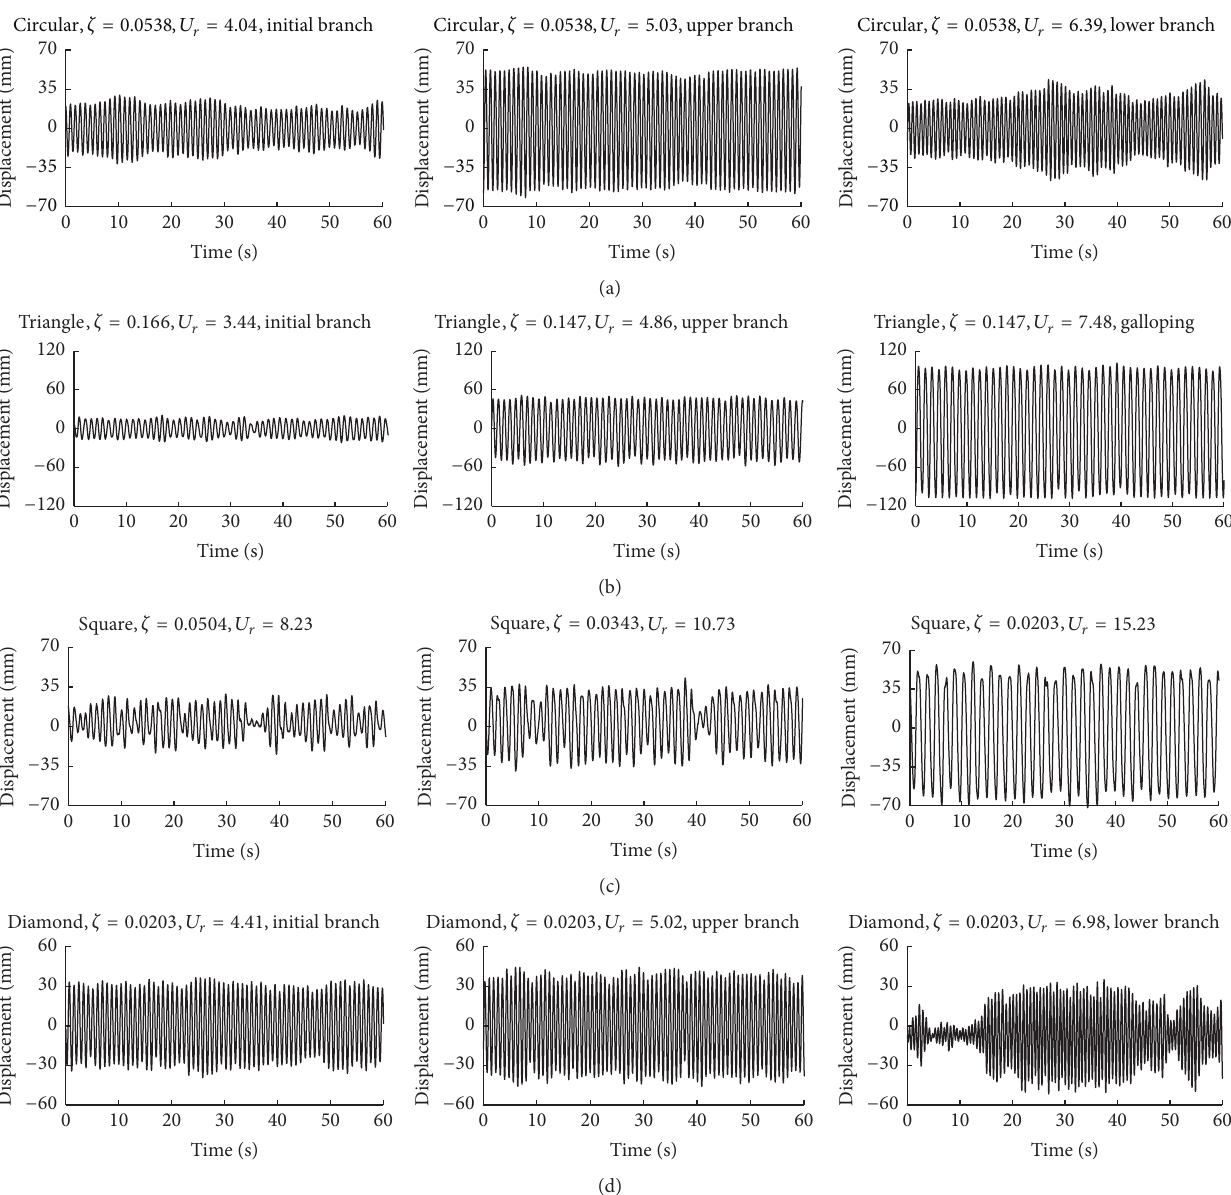
Figure 14: Selected examples of the time histories of displacement in each branch for the cylinders or prisms. (a) Circular cylinders; (b) regular triangle prisms; (c) right square prisms; (d) diamond